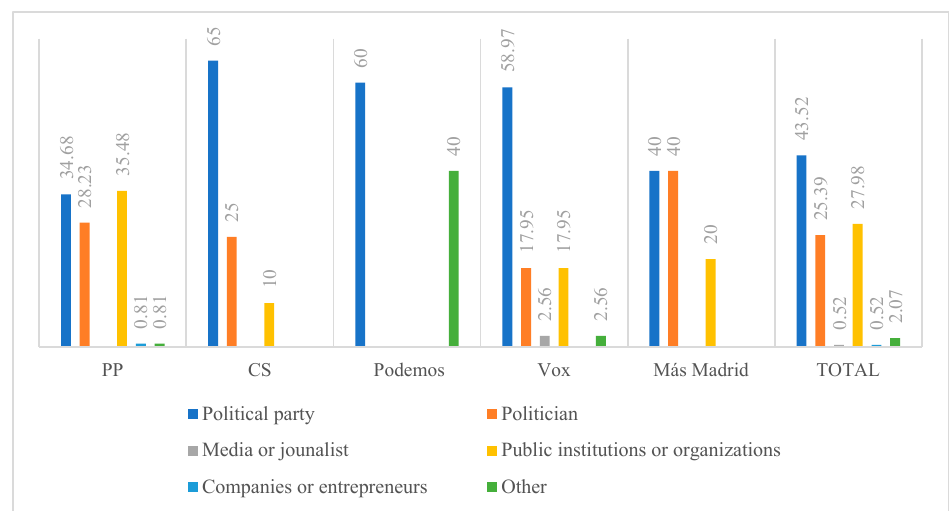
Figure 2. Subjects of criticism in Telegram messages from political parties (% within the user). Source: Self-made.